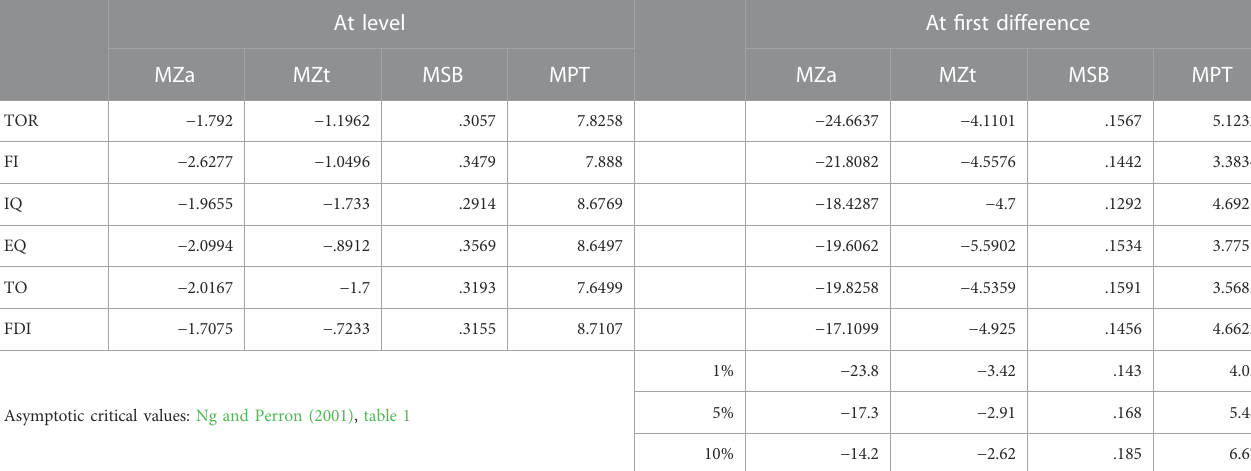
TABLE 5 Results of Ng-Perron unit root